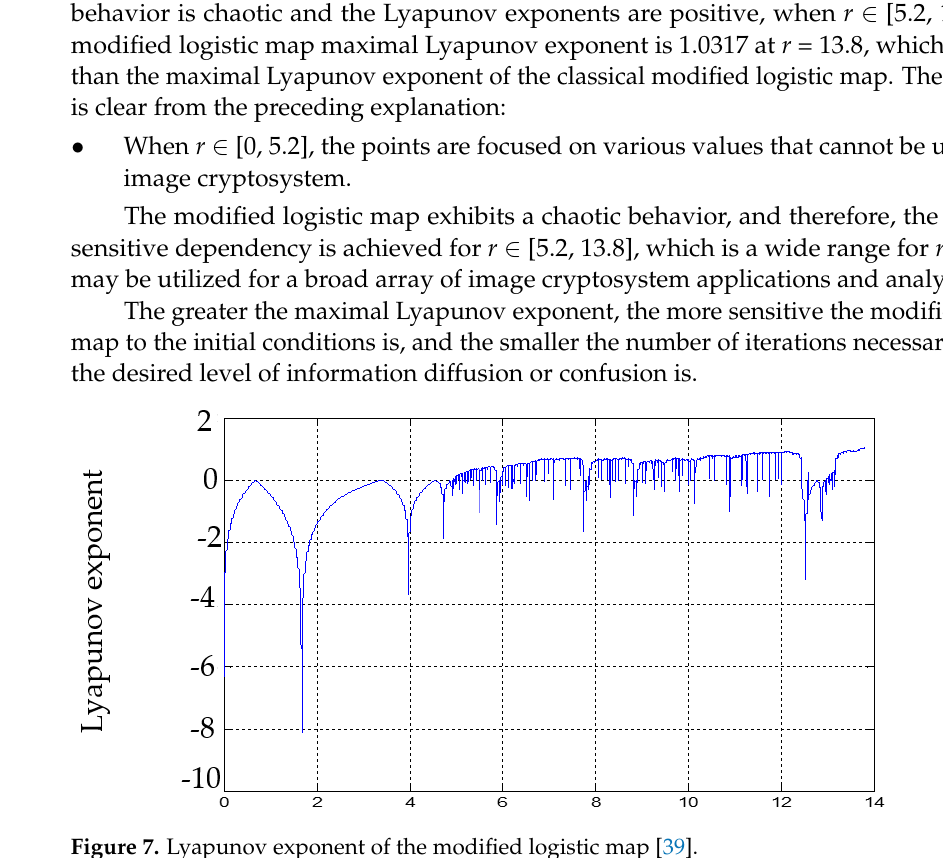
Figure 7. Lyapunov exponent of the modified logistic map